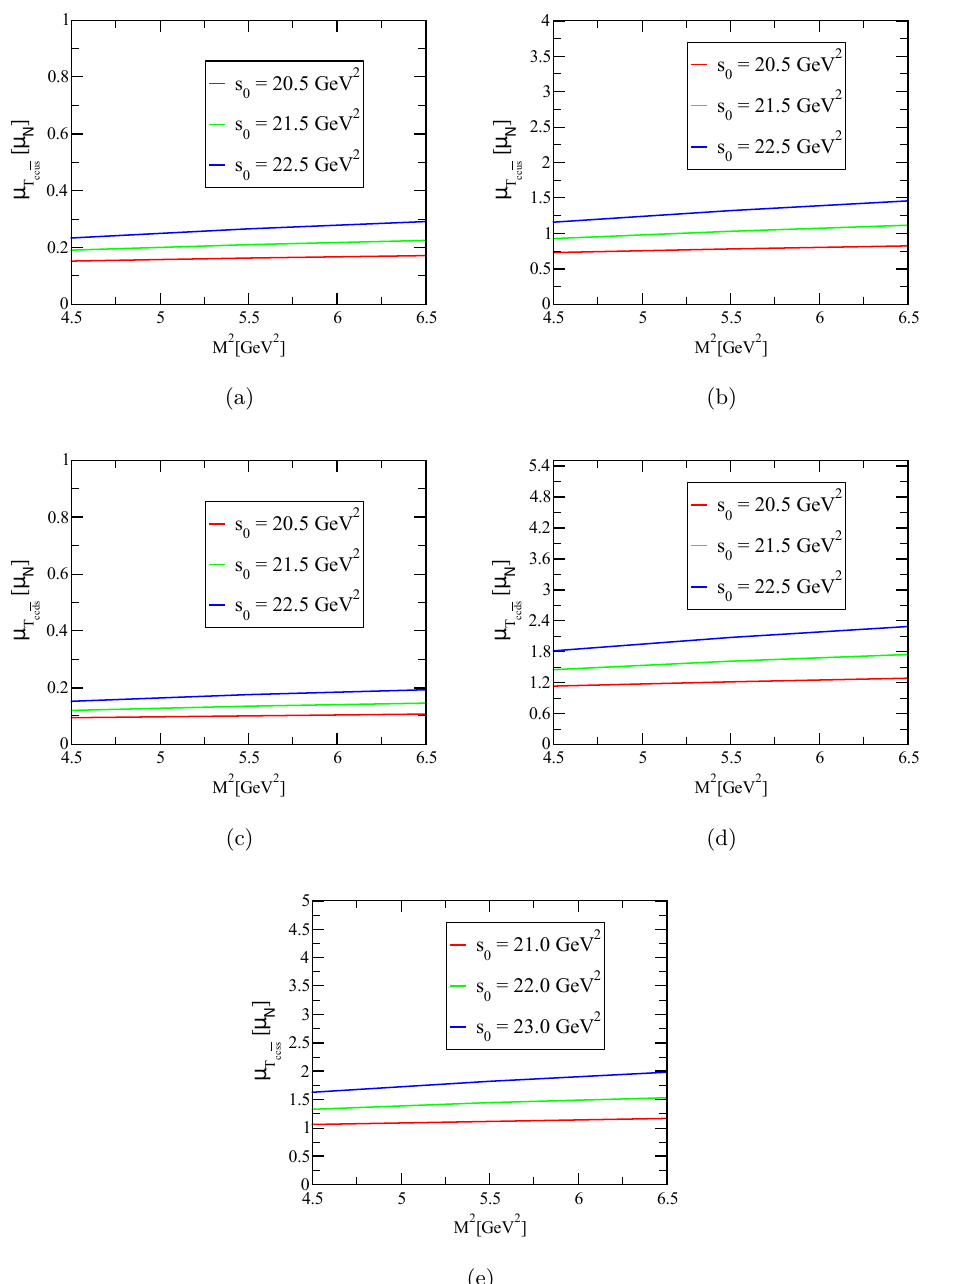
Figure 1 . Dependence of the MDMs of T cc ¯ q ¯ s and T cc ¯ s ¯ s tetraquark states on M 2 at three different values of s 0 ; (a) and (c) for the J 1 current; and (b), (d), and (e) for the J 3 µ